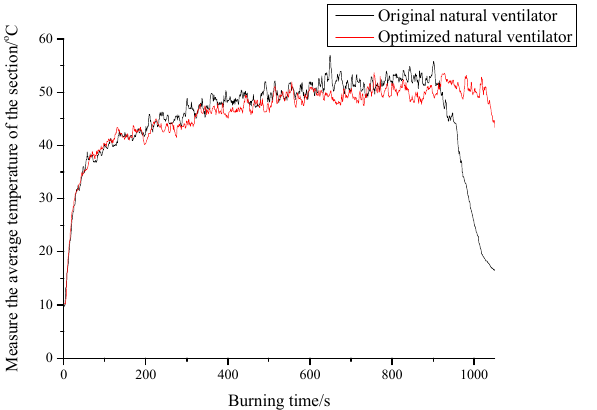
Figure 22. Temperature change of ventilator before and after optimization in the case of a fire environment (fire scale: 15 × 15 × 4 cm).